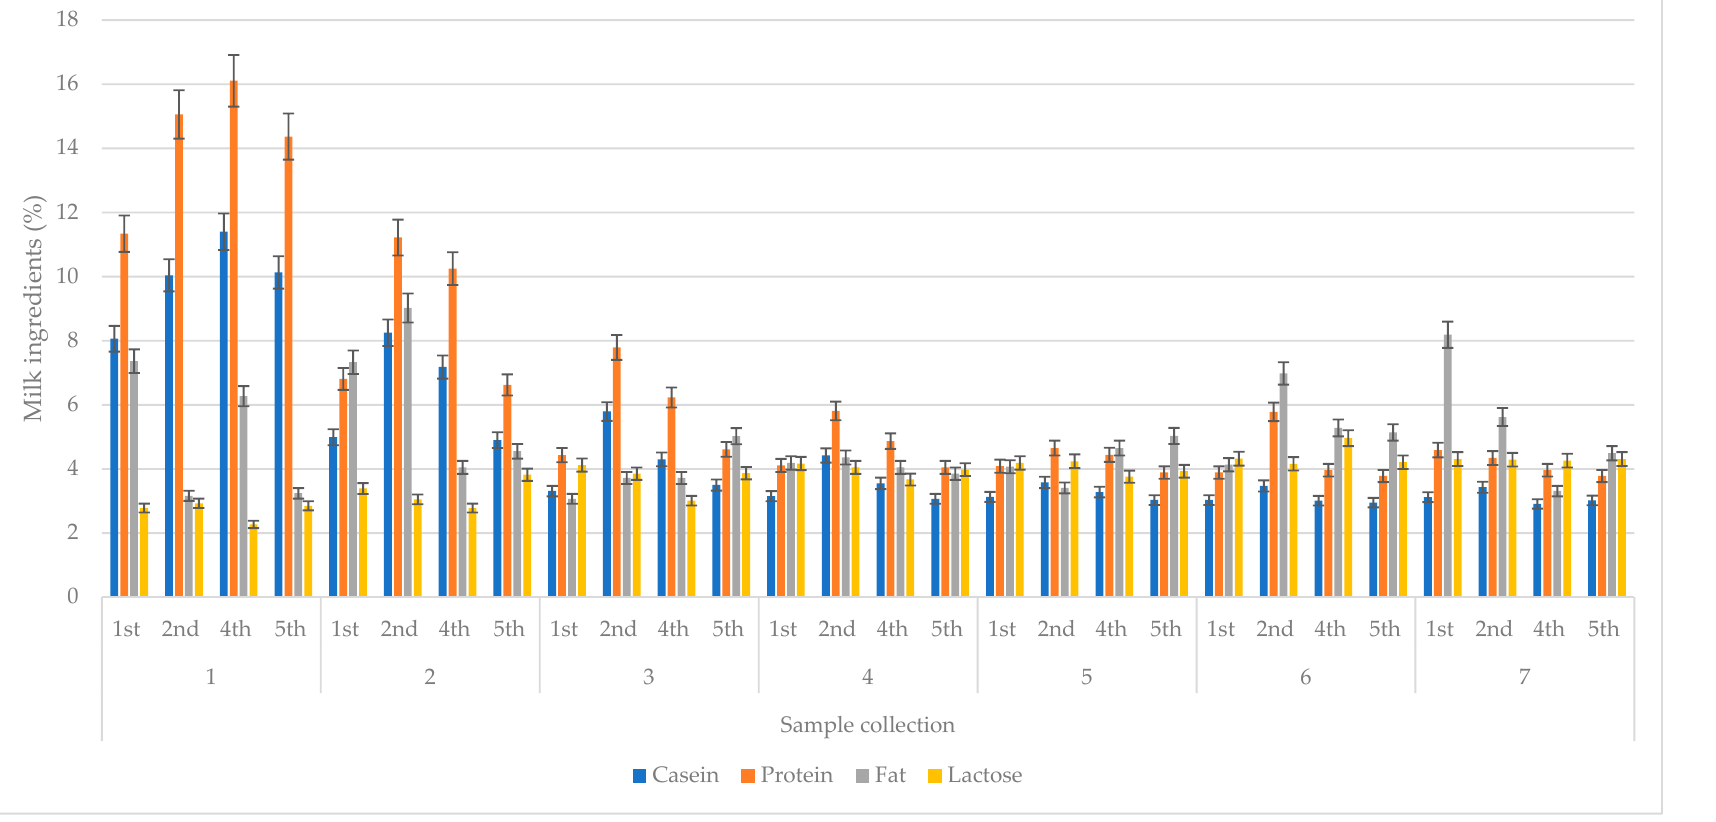
Figure 2. Changes in the basic chemical composition of colostrum (%) for subsequent collections, depending on parity. Data are presented as least squares means along with their standard errors of mean. Statistical differences between collection groups at p ≤ 0.01.